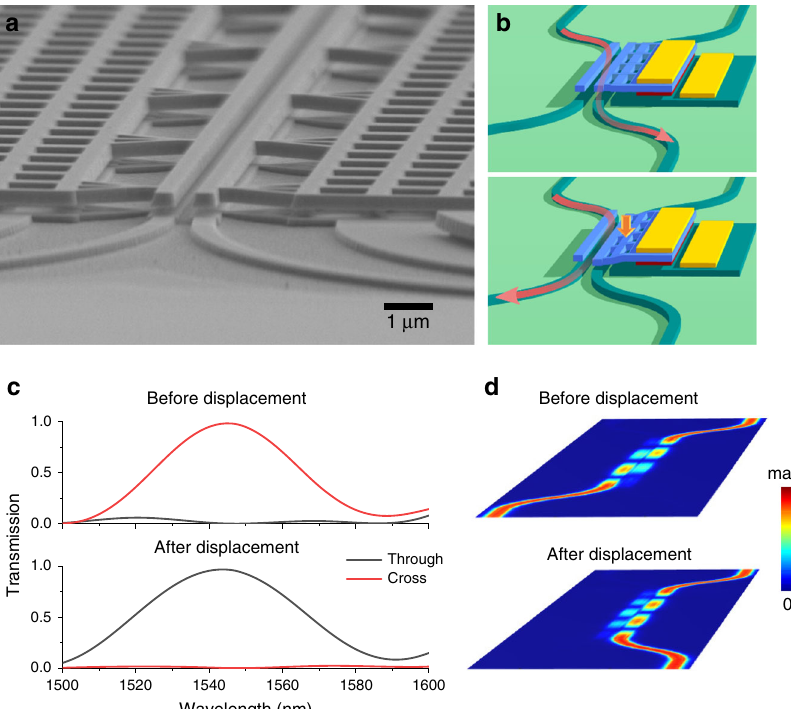
Fig. 1 Displacement transducing by nanomechanical directional coupler. a Scanning electron microscope (SEM) image of the nanomechanical directional coupler used as a transducer. b Schematic illustration of light passing through the direction coupler before (up) and after (down) actuation. c Simulated transmission and d simulated electric fi eld distribution (|E|) before and after displacement (55 nm) of an ideal device described in ref. 20 .